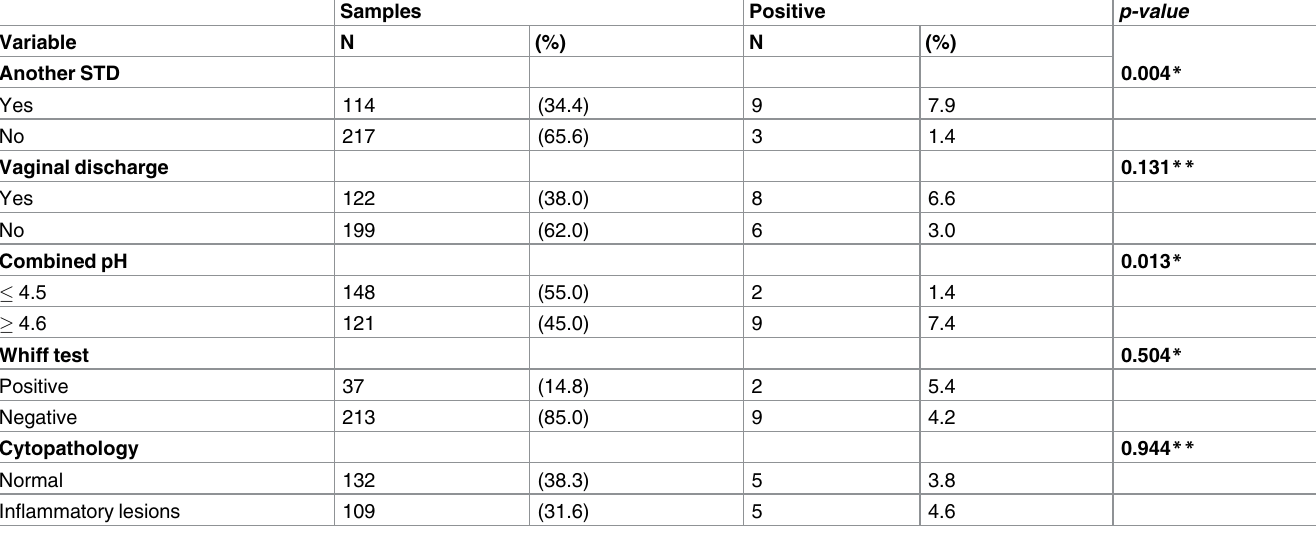
Table 4. Bivariate analysis of the laboratory data, clinical signs, and diagnosis of other STDs in women treated at the University Hospital of Rio Grande, Rio Grande do Sul, Brazil. Trichomoniasis was diagnosed using polymerase chain reaction (PCR) with the TVK3/7 primer set. Period between January2012 and January2015 (n =